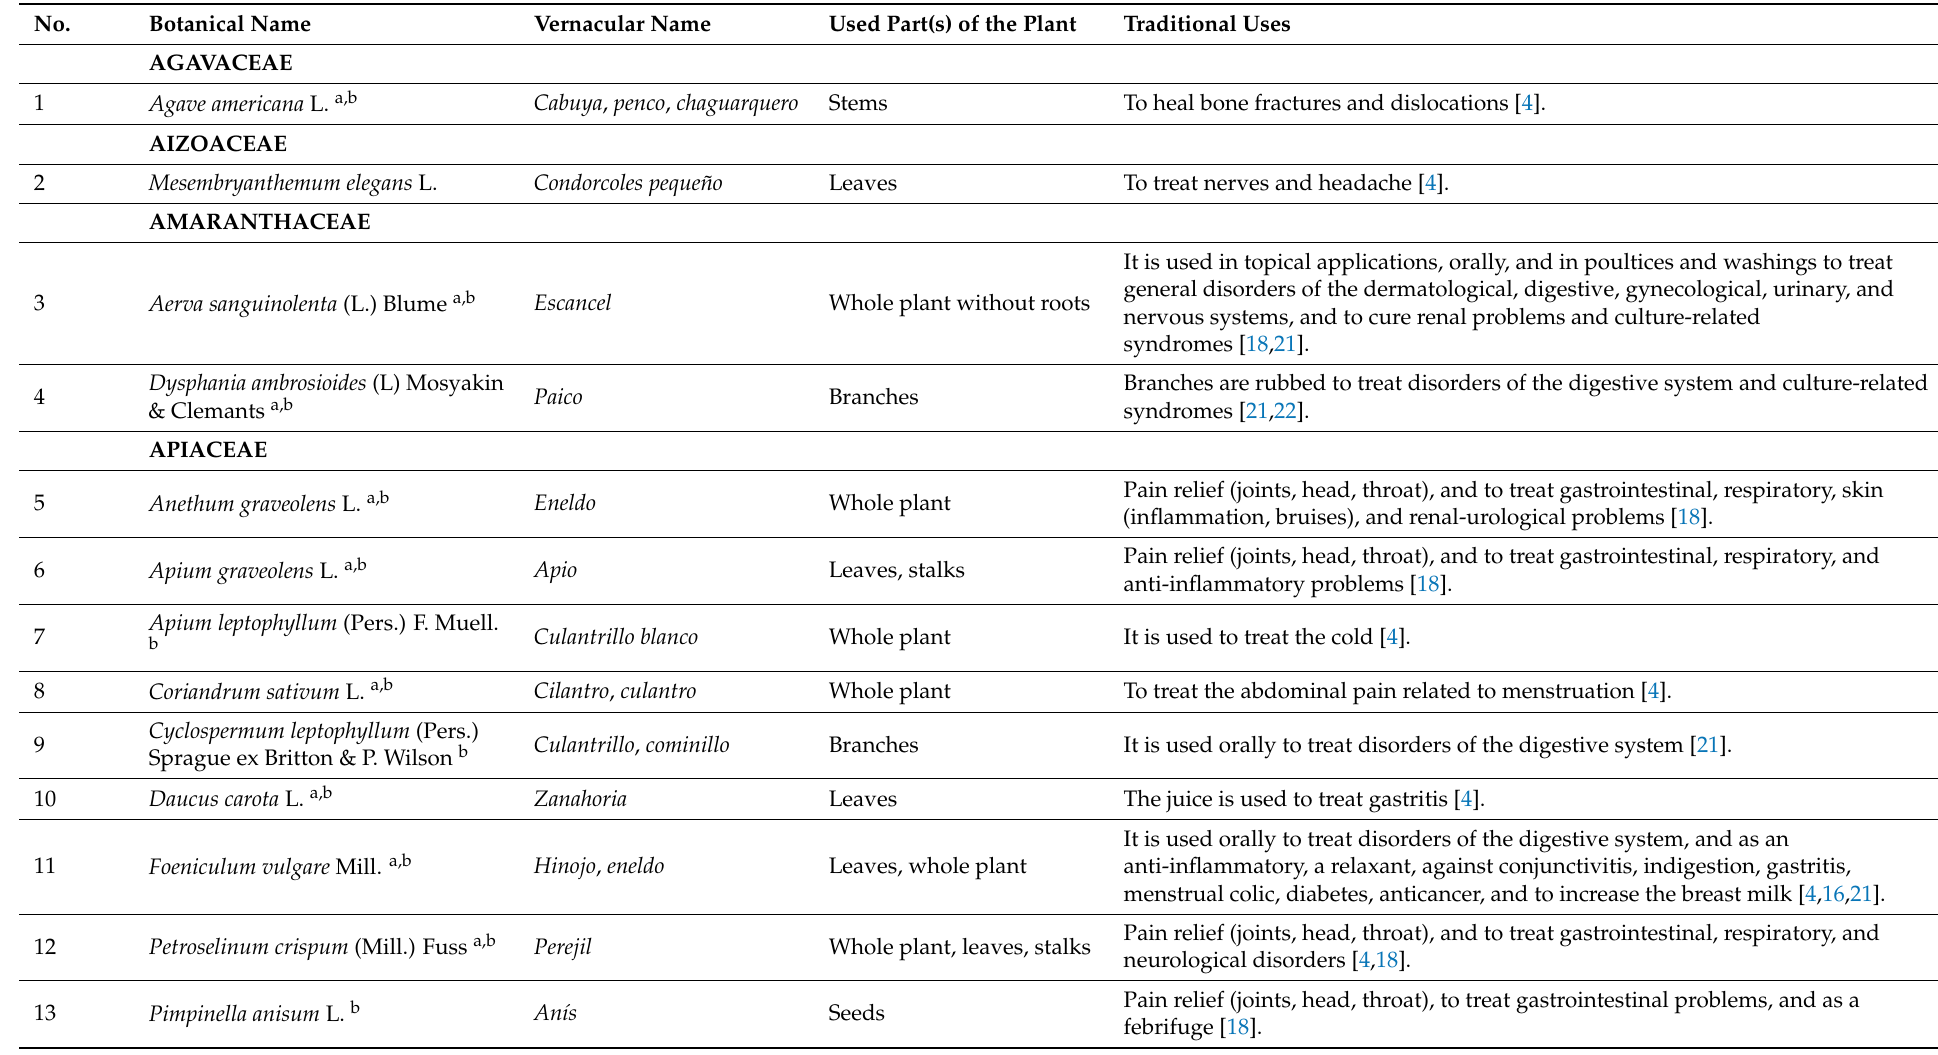
Table 2. Botanical and vernacular names, used part(s), and traditional uses of introduced medicinal